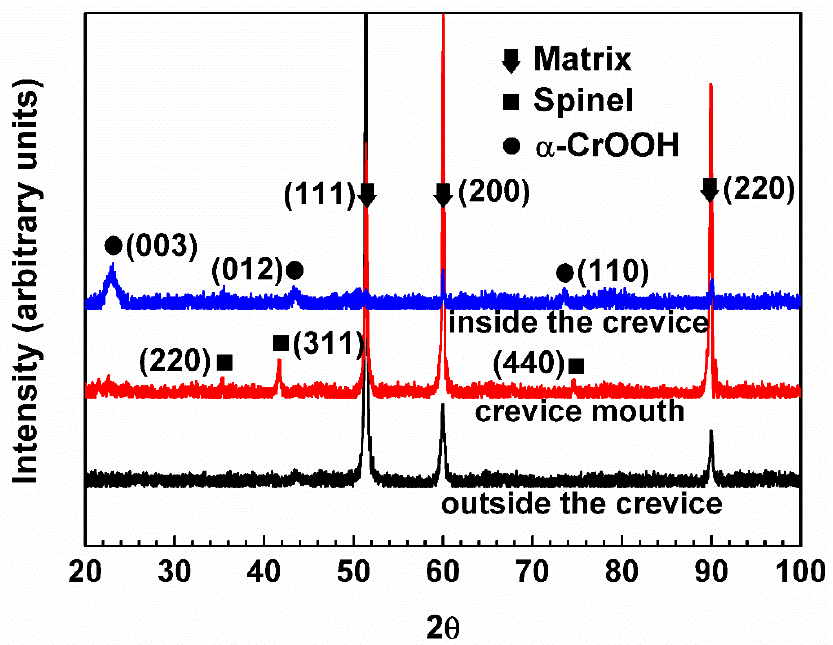
Figure 4. XRD analysis results of the oxide films at different regions of crevice sample exposed to 290 ◦ C NaCl solution.